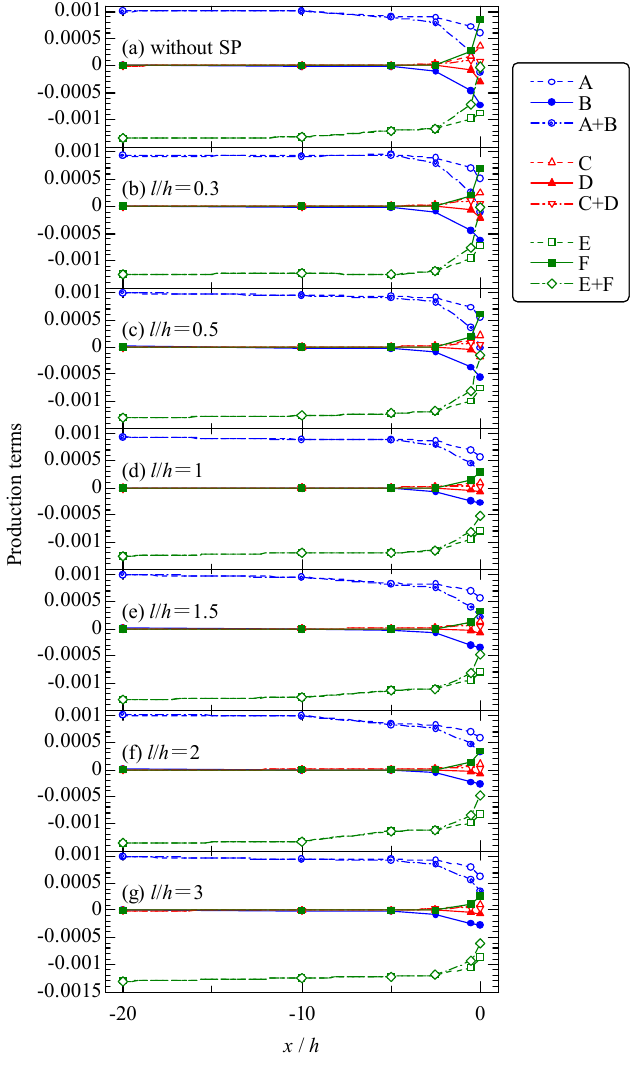
Fig. 6 Production terms of turbulent